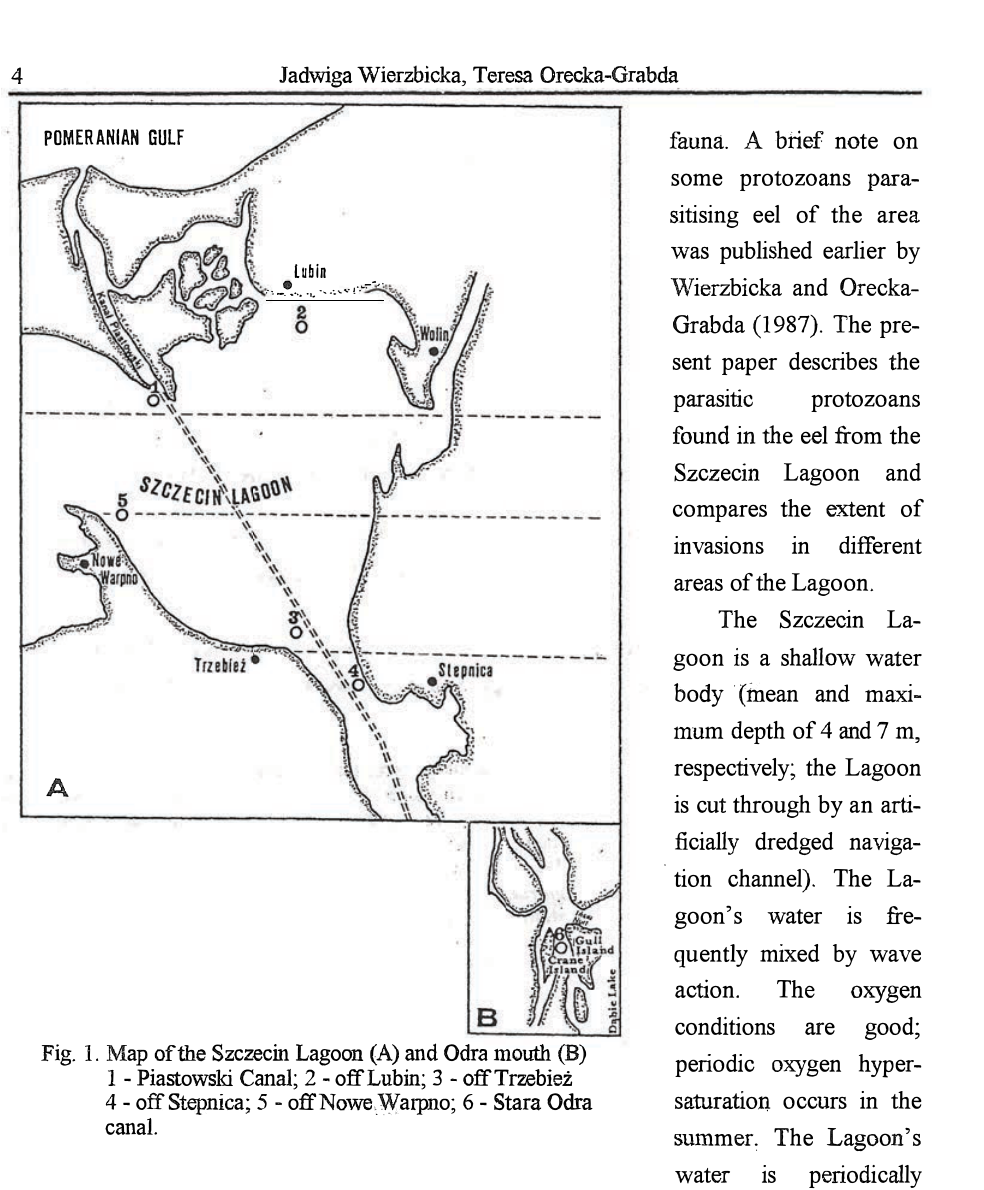
Fig. 1. Map of the Szczecin Lagoon (A) and Odra mouth (B) 1 - Piastowski Canal; 2 -off Lubin; 3 - offTrzebiez 4 -offStepnica; 5 - offNowe.Warpno; 6 - Stara Odra